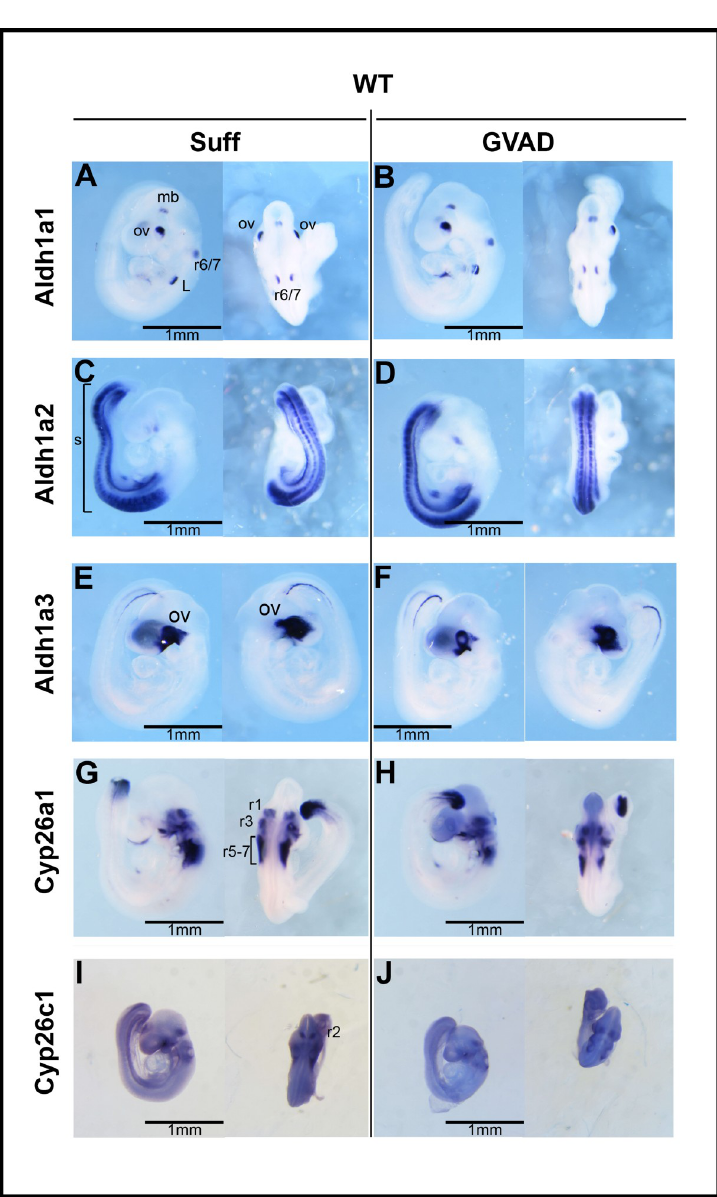
Fig 6. Effect of GVAD on expression of retinoid homeostasis genes. Lateral (left) and dorsal (right) views after whole-mount in situ hybridization of E9.5 WT embryos. Dams were administered a vitamin A-sufficient (Suff) or -deficient (GVAD) diet starting at E4.5. Embryos were probed for retinoic acid-generating RNAs: Aldh1a1 , Aldh1a2 , and Aldh1a3 , and retinoic acid-degrading RNAs: Cyp26a1 and Cyp26c1 , each as designated. For Aldh1a3 , left lateral (left) and right lateral (right) views are shown (E, F). Selective expression is noted for Aldh1a1 in rhombomere (r)6/7, midbrain (mb), foregut/presumptive liver site (A, B); for Aldh1a2 in somites(s) (C, D); for Aldh1a3 in optic vesicle (ov) (E, F); Cyp26a1 in r1, r3, r5, r7 (G, H) and Cyp26c1 in r2, r4, r6 (I, J). All images are shown to the same scale.